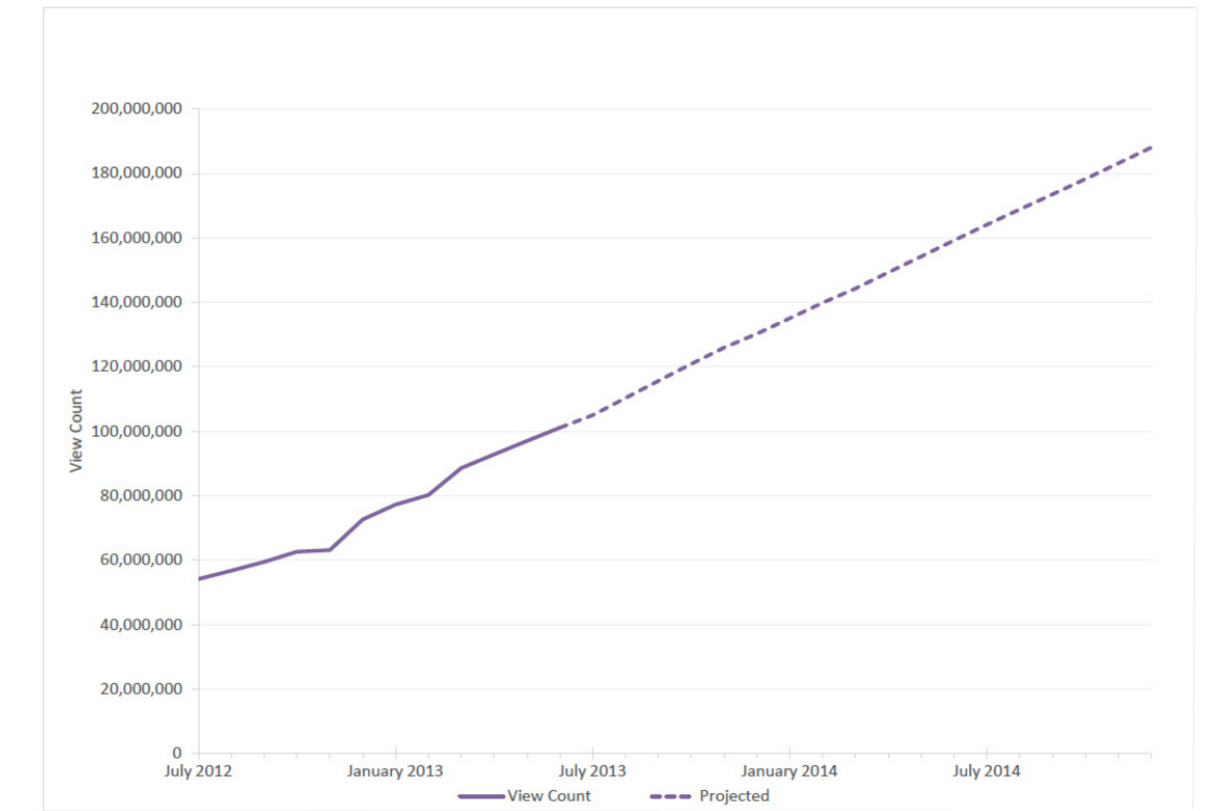
Figure 2. Total view counts for electronic cigarette-related videos from July 2012 to December 2014. View counts DO NOT include approximately 16% of videos with incomplete engagement